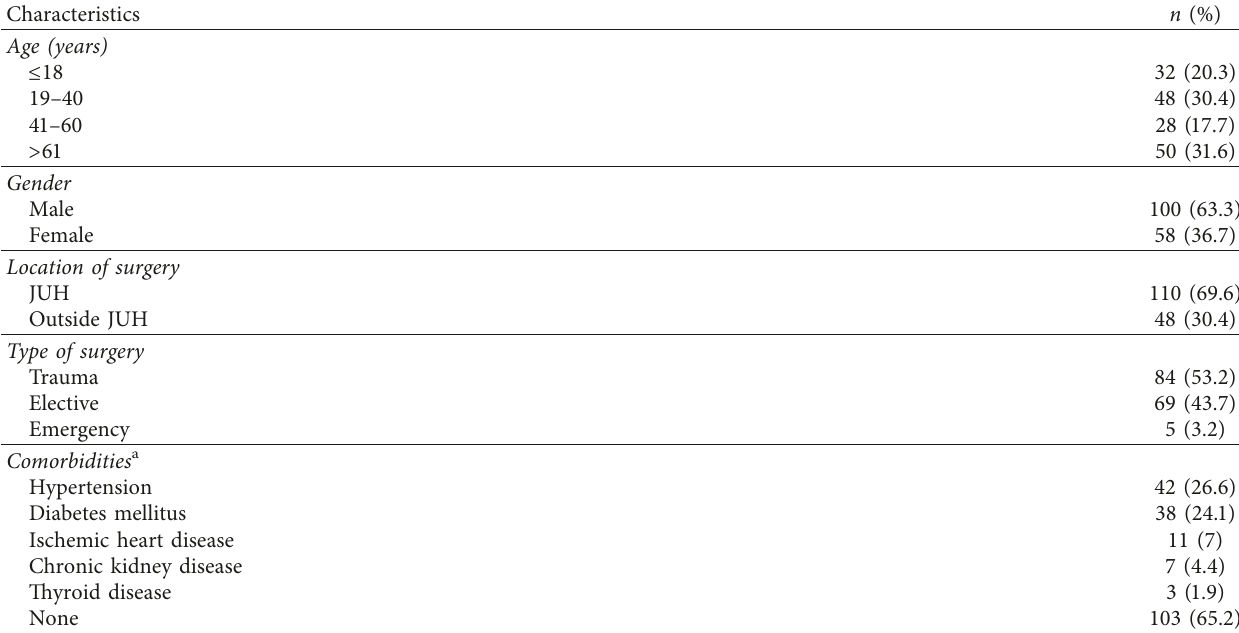
Table 1: Characteristics of cases with postoperative infection.